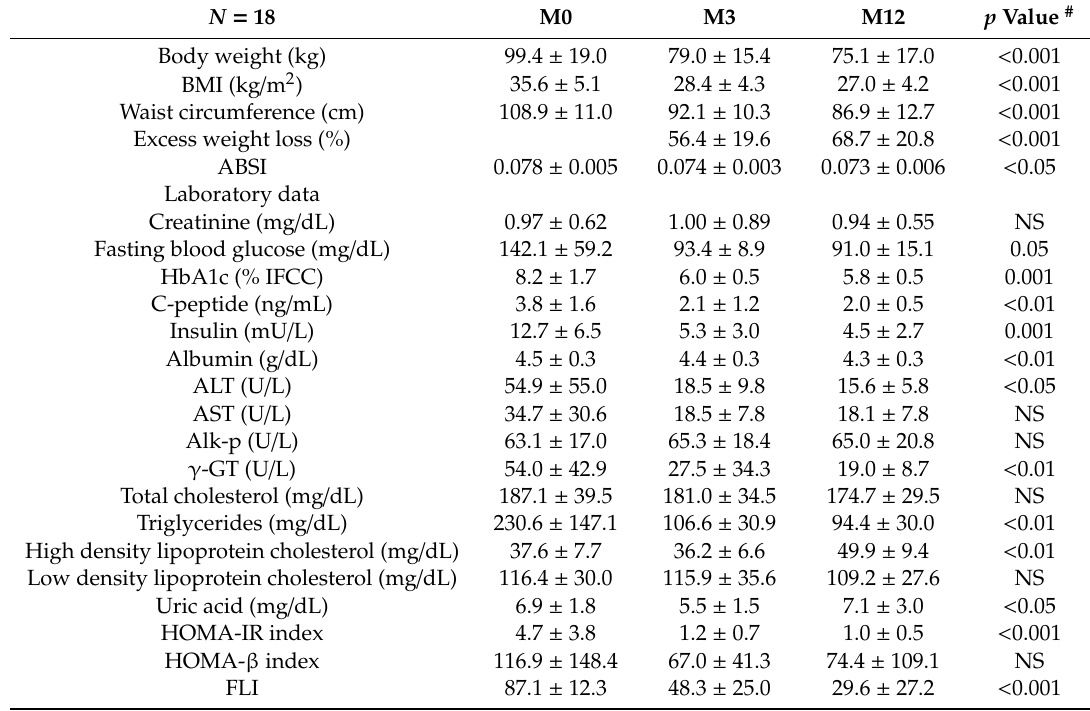
Table 1. Characteristics of the patients with obesity and type 2 diabetes mellitus before (M0) and 3 months (M3) and 1 year (M12) after sleeve gastrectomy.